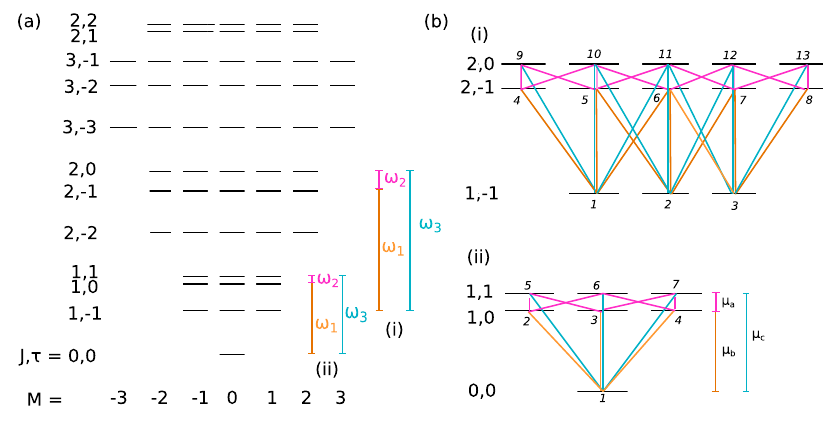
Fig. 1 Spectrum of a near-prolate asymmetric top. a Energies eigenvalues are sketched up to E 2,2 and labeled by the quantum numbers J , τ . The degenerate eigenstates in each level are labeled by the orientational quantum number M . By choosing a set of microwave fi elds resonant to particular transitions, only selected rotational levels are addressed. This is highlighted for the frequencies ω 1 = ( E 2, − 1 − E 1, − 1 )/ ℏ , ω 2 = ( E 2,0 − E 2, − 1 )/ ℏ , and ω = ( E − E ℏ in example (i), and ω = ( E − E ℏ , ω = ( E − E ℏ , and ω E E = _ in example (ii). b (i) and (ii) The subsystems of 3 2,0 1, − 1 )/ 1 1,0 0,0 )/ 2 1,1 1,0 )/ 3 ¼ ð 1 ; 1 (cid:2) 0 ; 0 ÞÞ the asymmetric top resulting from resonant microwave driving with set of frequencies depicted in a (i) and a (ii), respectively, with the colored lines indicating transitions induced by x − , y − , and z − polarized fi elds with frequencies ω 1 (orange), ω 2 (pink), and ω 3 (turquoise). Here, μ a , μ b , and μ c are the Cartesian components of the dipole moment responsible for the transition indicated by the vertical bars. The small numbers indicate the states of the